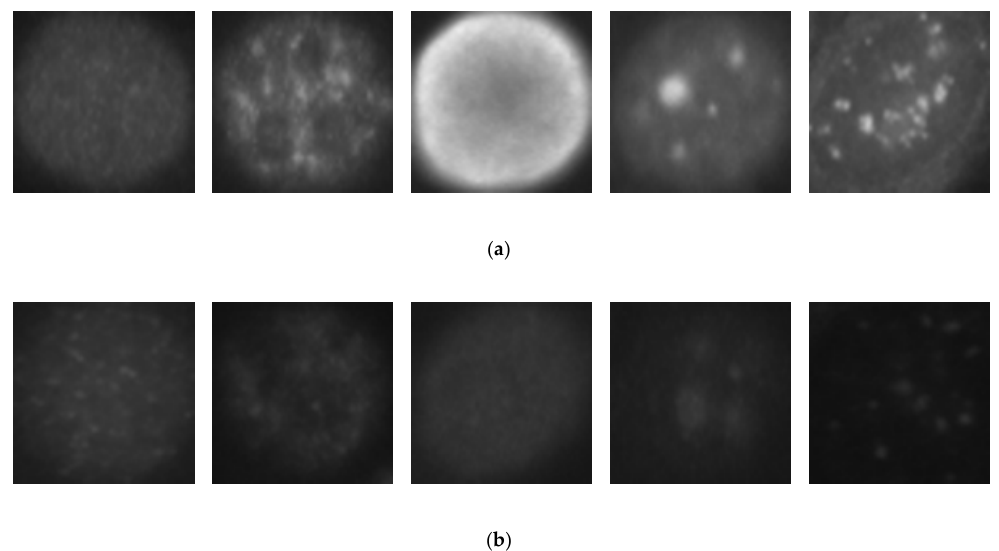
Figure 5. Example images from the SNPHEp-2 dataset. ( a ) The positive fluorescence illumination images. ( b ) The negative fluorescence illumination images. In ( a ) and ( b ), from the left to the right: homogeneous, coarse speckled, fine speckled, nucleolar and centromere cells. The dataset contains 1884 HEp-2 cell images. The images were all extracted from 40 di ff erent cell specimens. From the 40 specimens, 20 were used for the training sets and the remaining 20 were used for the testing sets. In total, there are 905 and 979 cell images for the training and testing sets, respectively. Each set (training and testing) contains five ‐ fold validation splits of randomly selected images. In each set, the different splits are used for cross ‐ validating the different models, each split containing 450 images approximatively. During the experiments, the images were upscaled to 112 × 112 in order to use them in our network. In order to improve the learning capability of the network, data augmentation was applied over the dataset. In every splitting set of the training data, the cells were rotated by 360° in steps of 18°, as done in [22,28]. Thus, the original training set was expanded by a factor of 20, a 360° quadrant containing 20 portions of 18°. We found that augmenting the training set greatly improves the accuracy over the testing set. All the results shown subsequently are those obtained after applying data augmentation in this form.